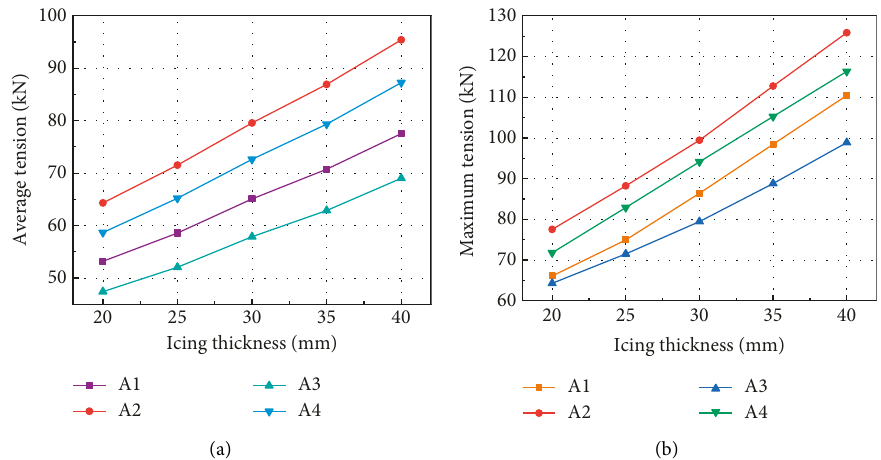
Figure 9: Relationship between icing thickness and conductor hanging point tension: (a) Average tension, (b) Maximum tension.